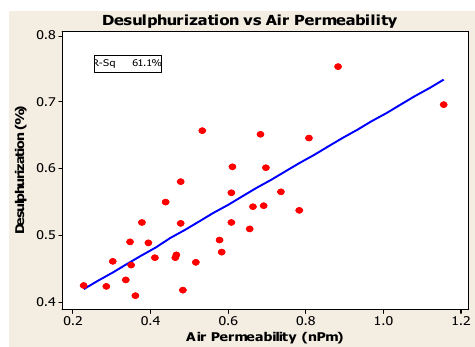
Figure 15. Desulfurization vs. permeability.